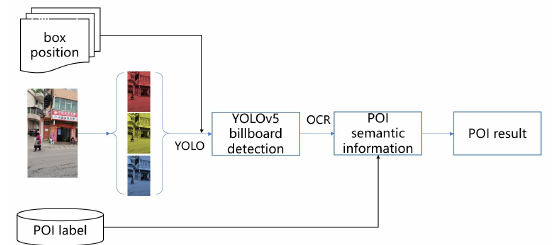
Figure 2. The workflow of urban POI mapping using the street-level imagery.